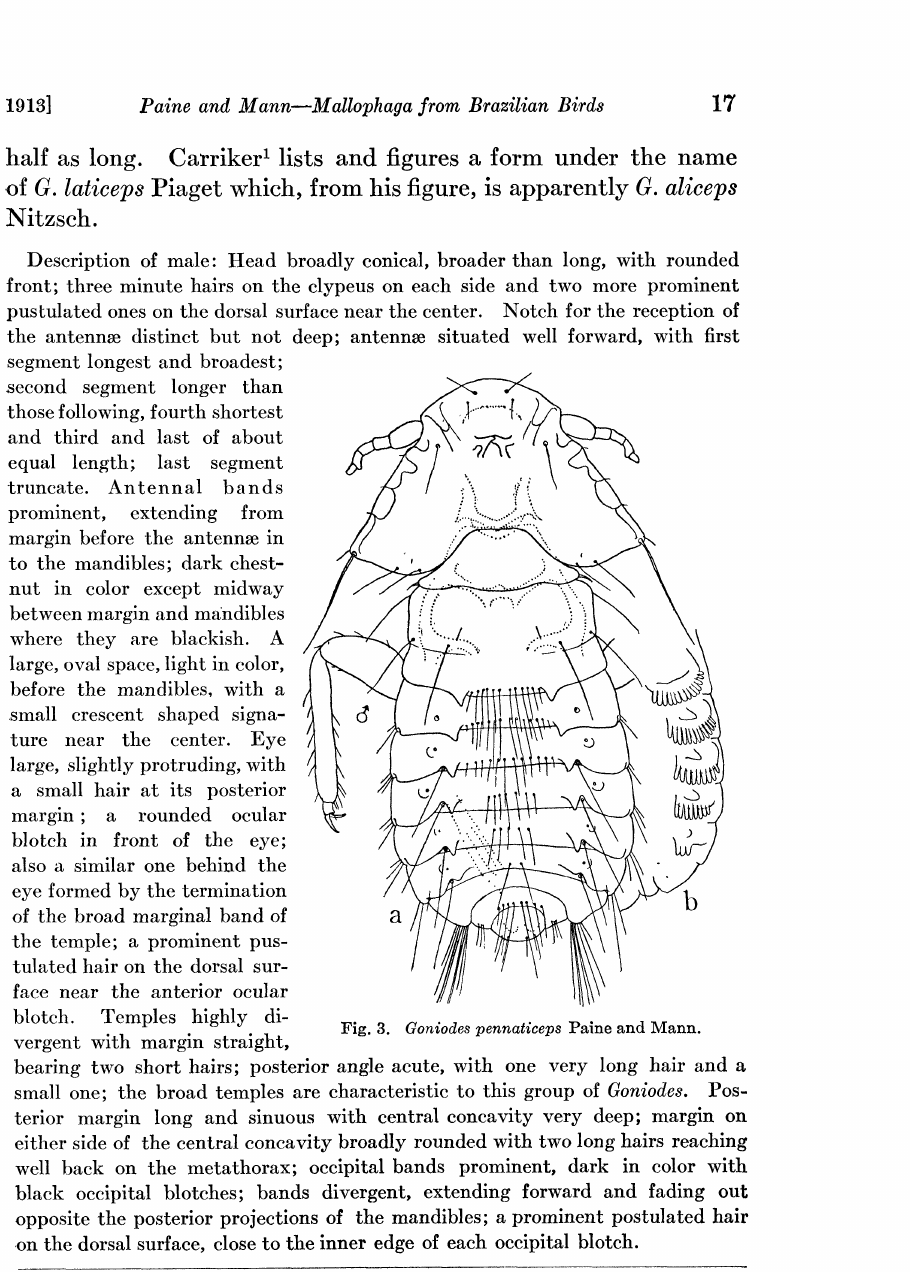
vergent with margin